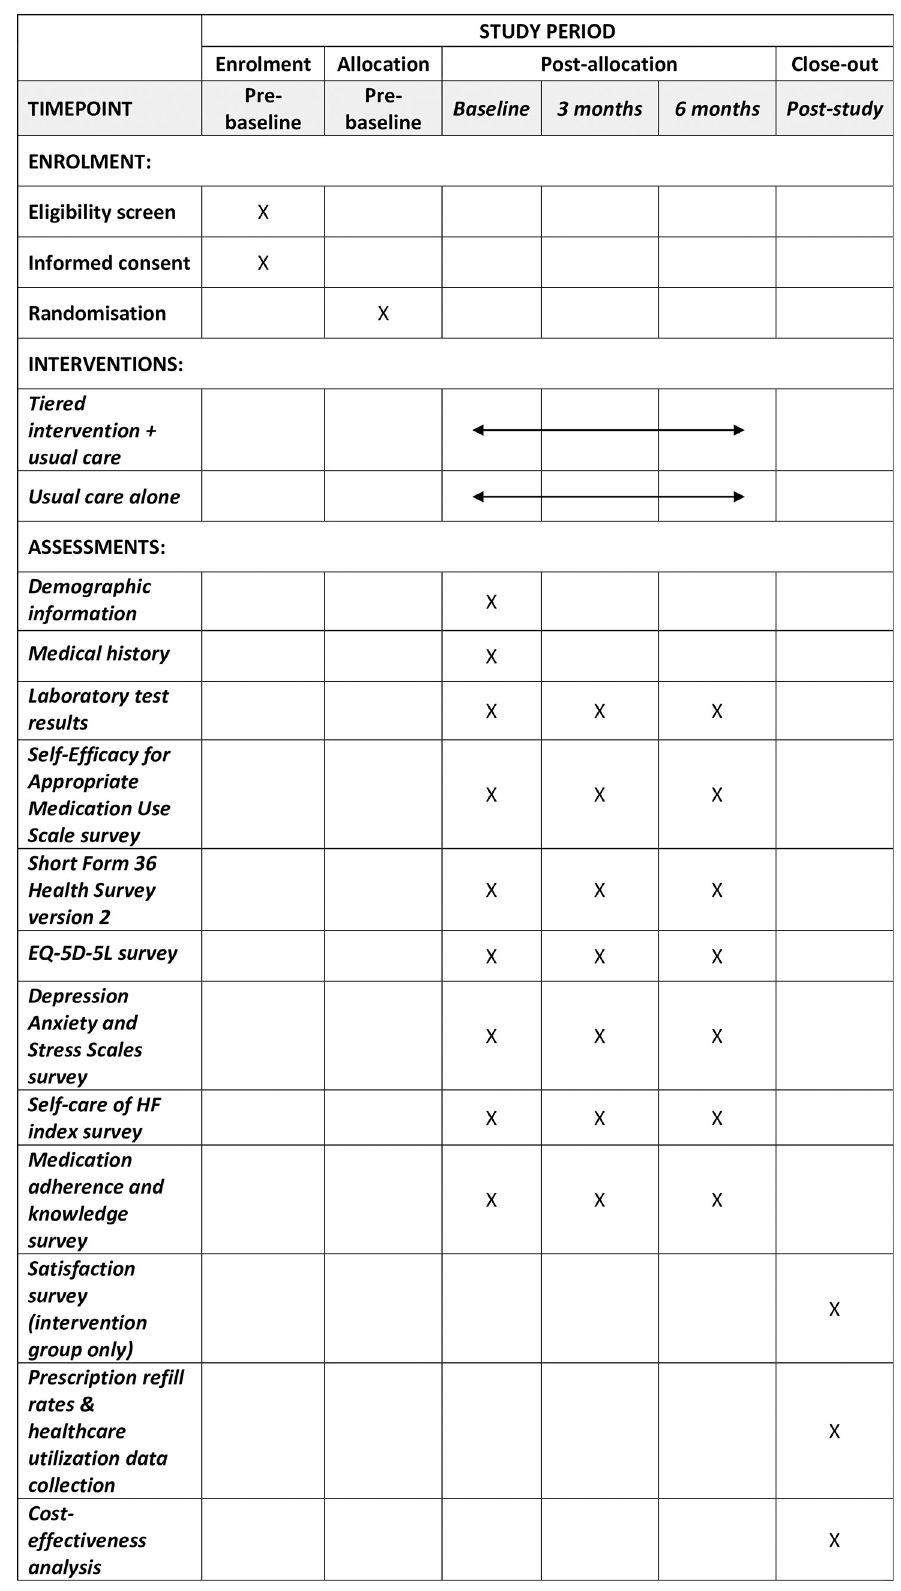
Fig 1. Schedule of enrolment, interventions, and assessments. https://doi.org/10.1371/journal.pone.0263284.g001 PLOS ONE | https://doi.org/10.1371/journal.pone.0263284 February 4,